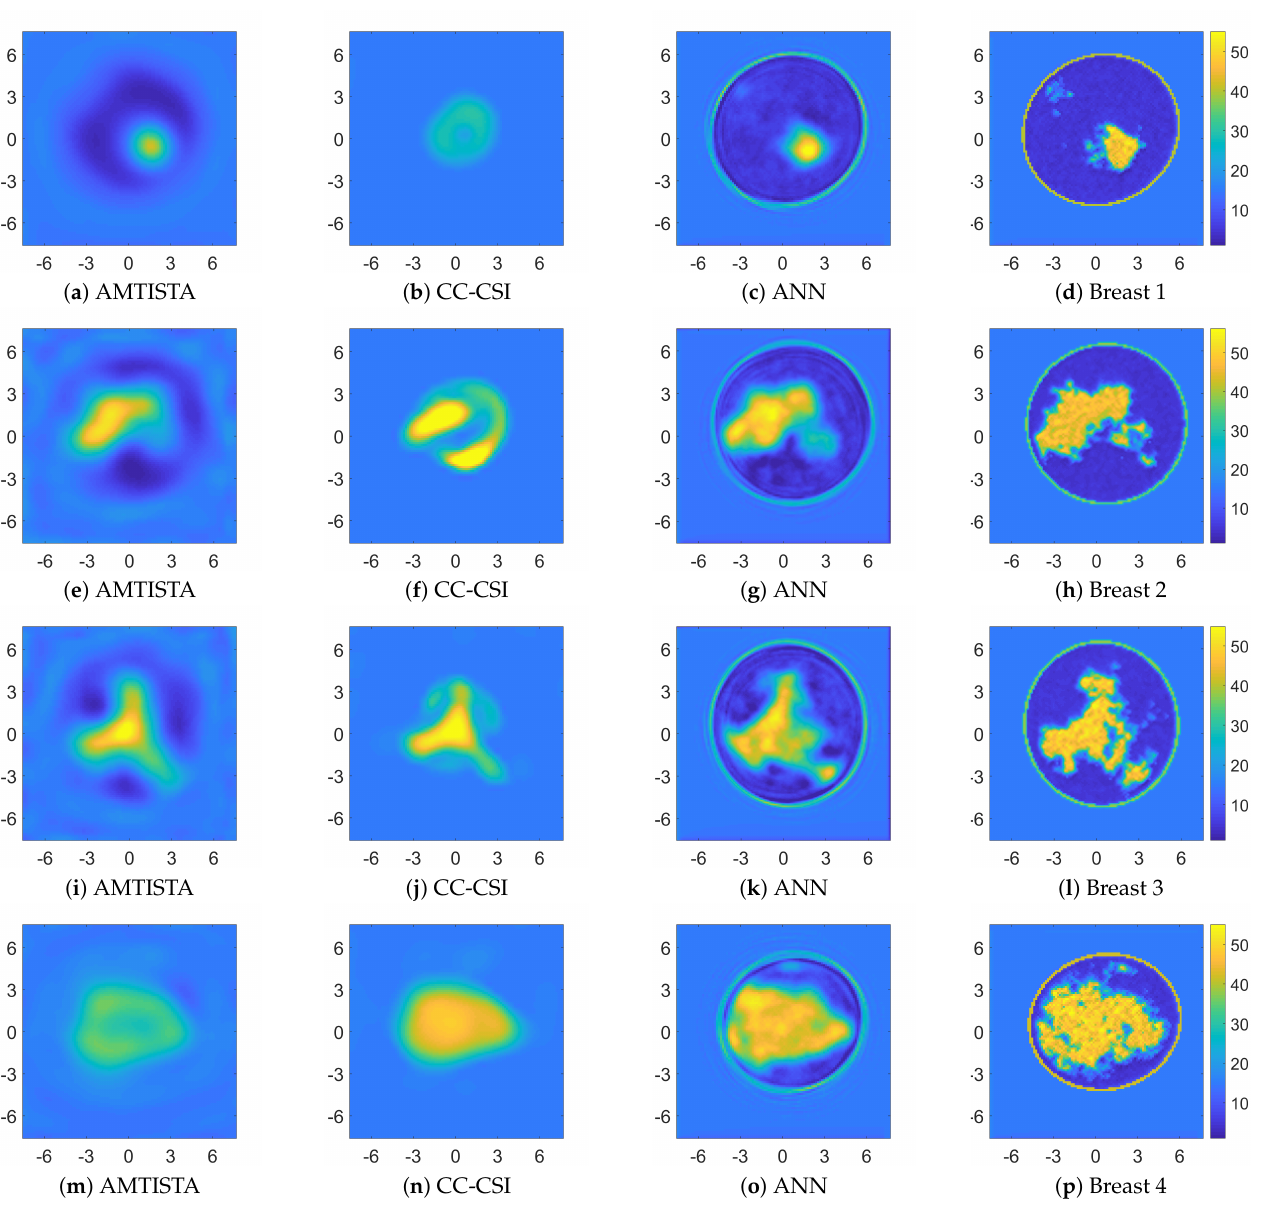
Figure 6. Comparison between recoveries related to four different breast profiles (one per each class). Retrieved relative permittivity maps (dimensionless quantity) for AMTISTA (DBIM formulation as reported in [70]) ( a , e , i , m ), cross-correlated CSI (CC-CSI) [87] ( b , f , j , n ), and proposed ANN ap- proach ( c , g , k , o ). Reference permittivity maps are reported in ( d , h , l , p ). Both the x and y axes are in centimeter